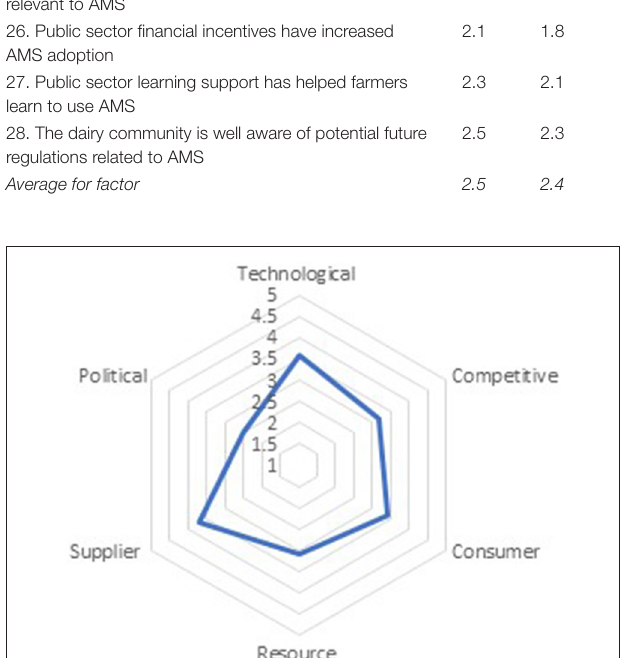
FIGURE 3 | Average factor scores for the six uncertainties across roles (retailer and non-retailer) (scale of 1–5 where 1 = strongly disagree, 5 = strongly agree).